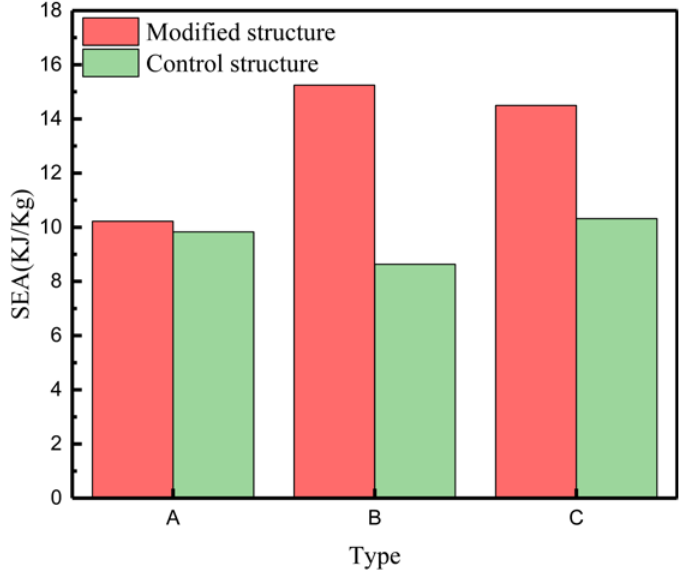
Figure 19. Specific energy absorption (SEA) under modified and control